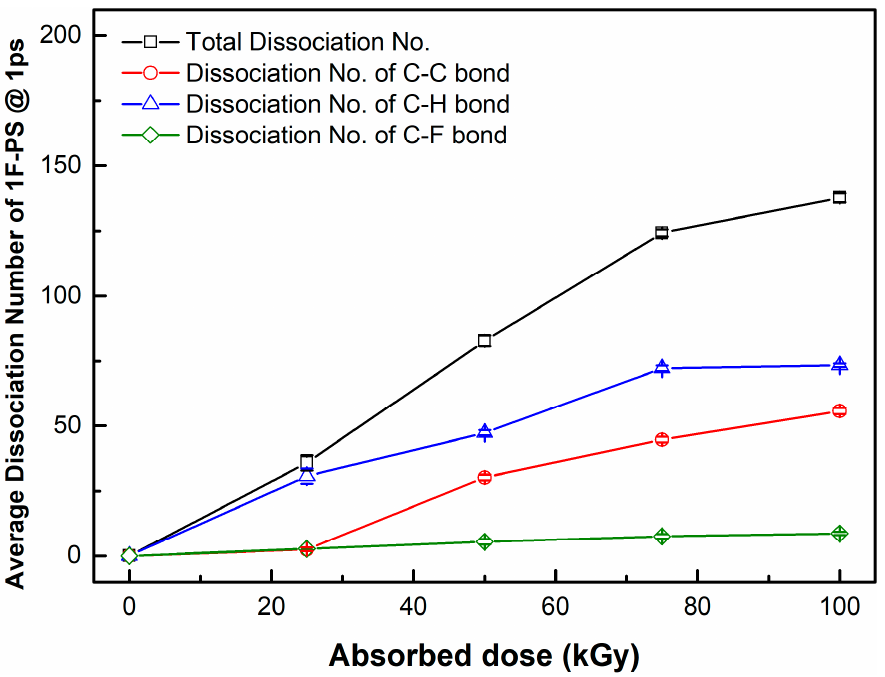
Figure 6. Average dissociation number of each bond in 1F-PS (poly(4-fluorostyrene)) at 1 ps.